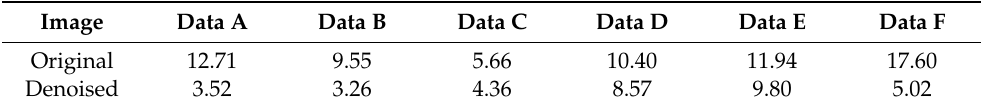
Table 4. Parameter setting of three